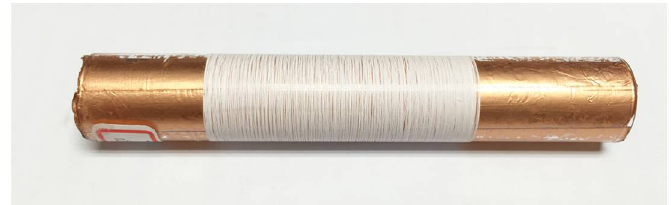
Figure 4. PVDF fibers collected by the hollow copper